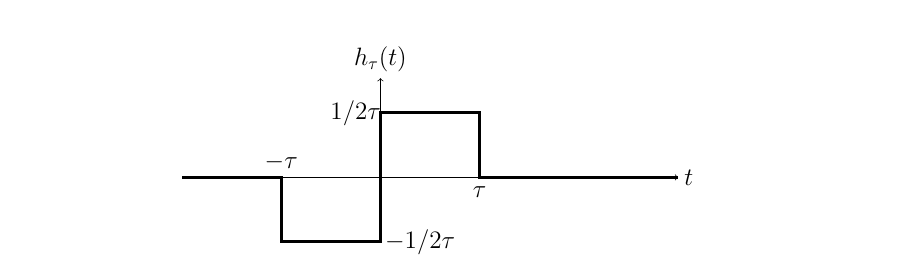
Figure 4: Time window of the Allan variance